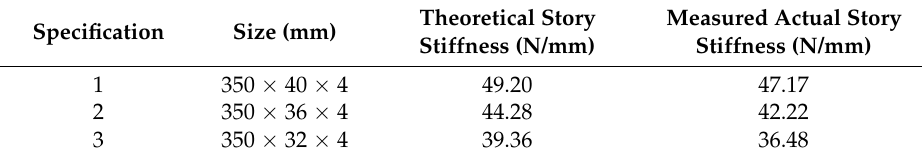
Figure 12. Three specifications of the steel bars in the experiment. Table 2. The parameters of the steel column bars and the story stiffness.